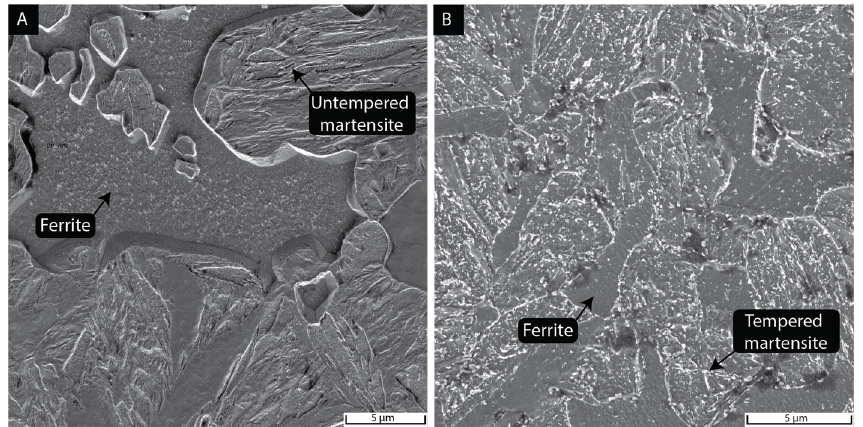
Figure 5. Scanning electron micrographs of 1-wt% Ni DP_70% in the as-quenched condition ( A ) and after temper ( B ). Untempered martensite displays a needle and rough appearance while ferrite is present as a smooth area. Tempered microstructure displayed carbides at boundaries and within martensitic laths.